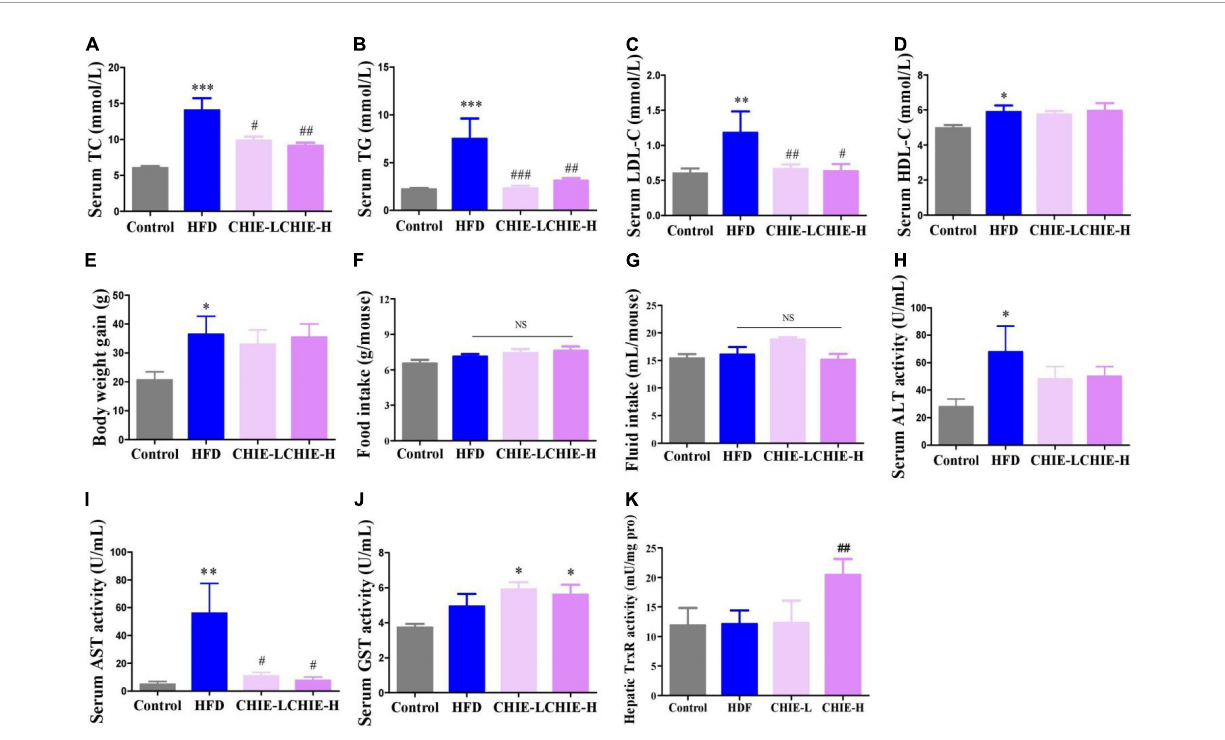
FIGURE5 Effects of CHIE (0.72% or 2.16% in drinking fluid, m/v) on hyperlipidemia in golden hamsters fed a high-fat diet. Treatments were introduced in animal experiment 5. (A–D) Levels of TC, TG, LDL-C and HDL-C in serum. (E–G) Body weight gain and food and fluid intakes. (H,I) Levels of ALT and AST in serum. (J,K) Enzyme activity levels of GST and TrxR in liver. ∗ p < 0.05, ∗∗ p < 0.01, ∗∗∗ p < 0.001, compared to control. # p < 0.05, ## p < 0.01, ### p < 0.001, compared to ALX. NS, p > 0.05. Data are presented as mean ± SEM ( n =